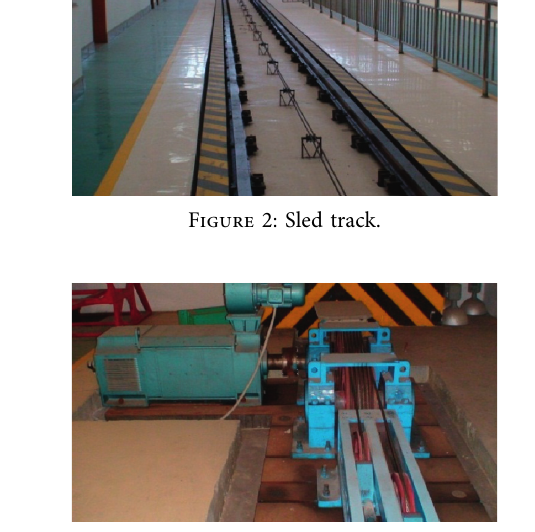
Figure 3: Traction system.